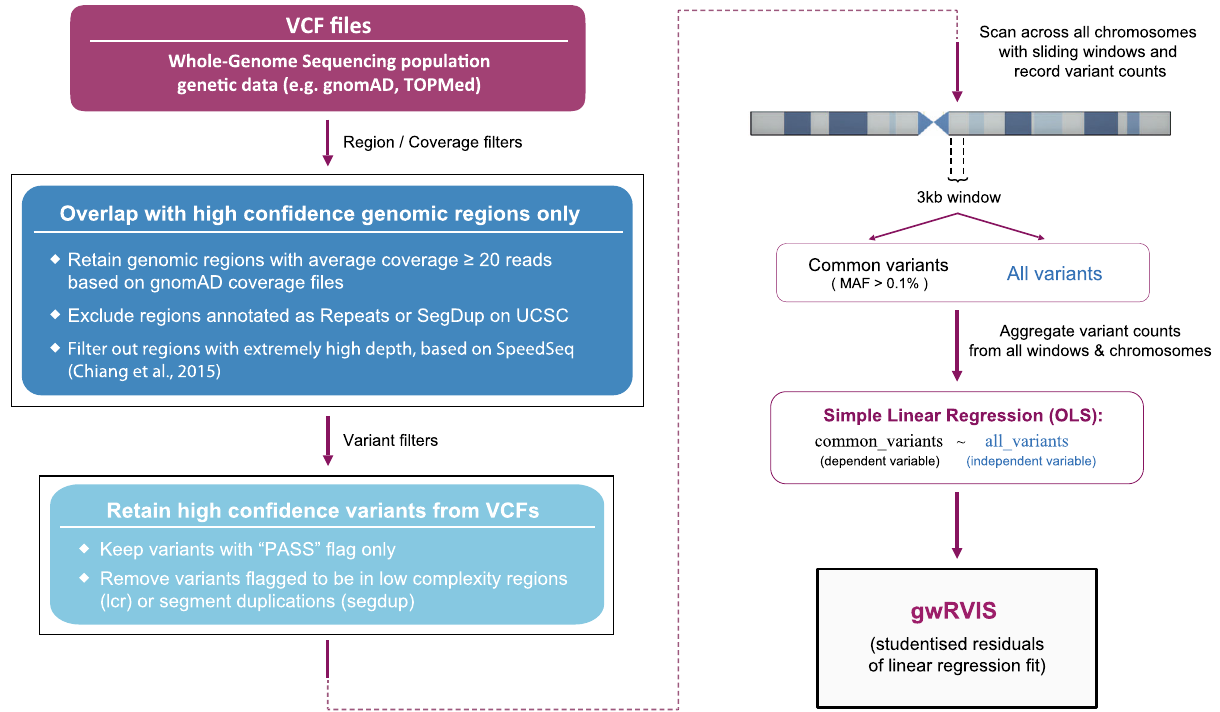
Fig. 1 Genome-wide residual variation intolerance score (gwRVIS). Flowchart for calculation of single-nucleotide resolution gwRVIS from whole-genome sequencing population genetic data (e.g., TOPMed and gnomAD), including relevant fi ltering steps (regarding depth coverage, repeat sequences, and variant